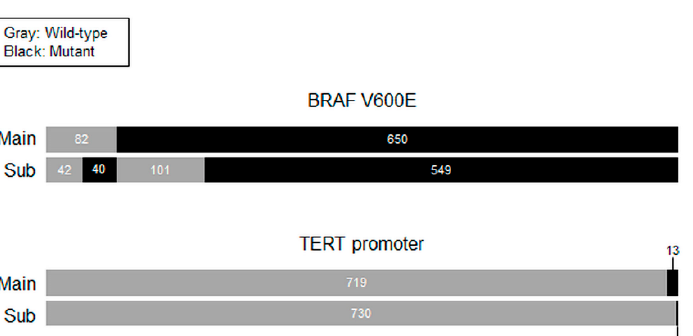
Figure 2. BRAF V600E and TERT promoter mutations in preoperatively diagnosed bilateral PTCs. Mutational status in main lesions and